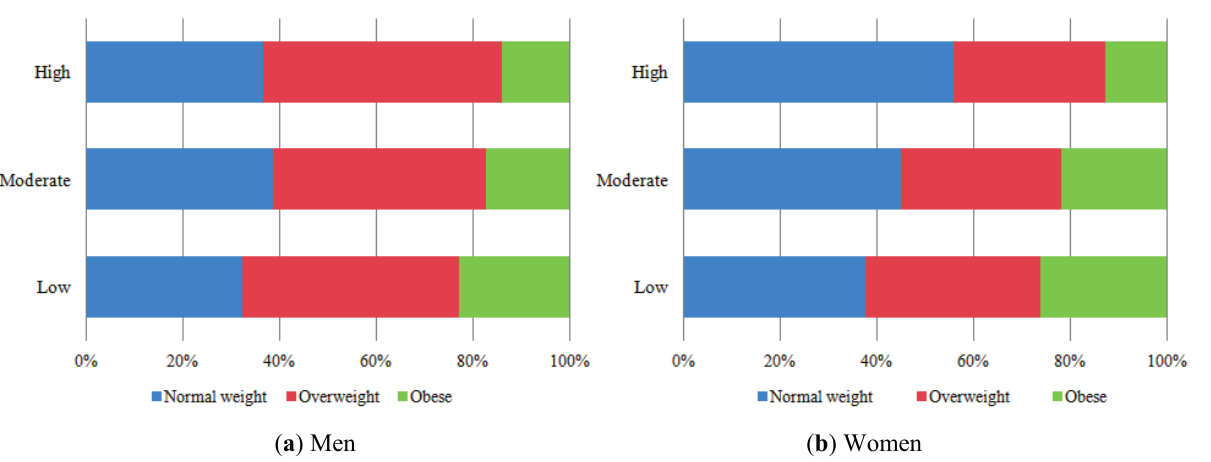
Figure 1. Prevalence of body dissatisfaction among men and women, according to the physical activity (35–64 years-old). ELSA-Brasil (2008–2010).